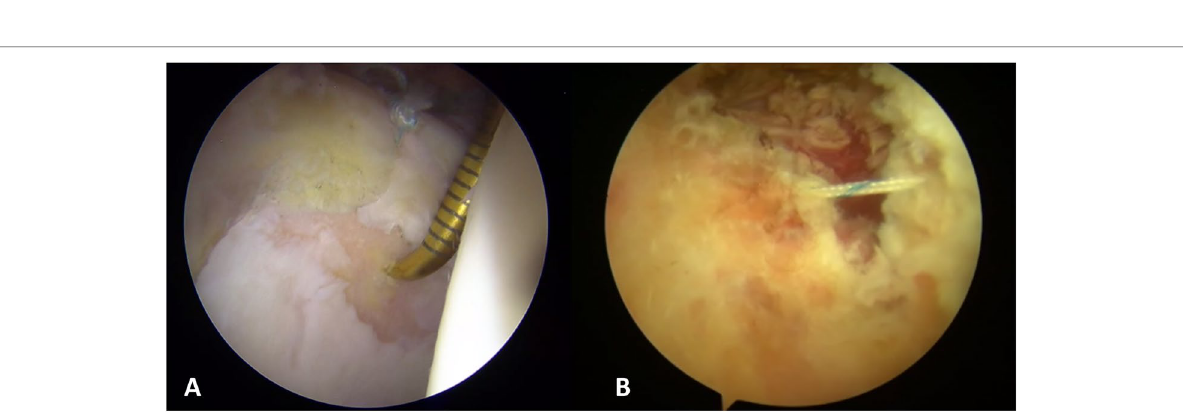
Fig. 3 Arthroscopic view from antero-lateral portal of a borderline displastic hip: acetabular Chondropathy area grade 4 according Outerbridge are detected and treated with microfractures after performing a labral suture with one anchor ( A ). Capsular plication ( B ) is performed at the end of the intrarticular